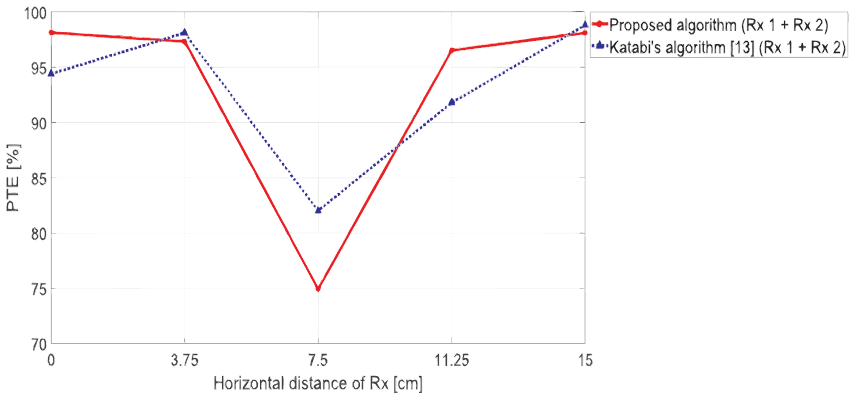
Figure 7. The sum of PTE results for all Rx coil. Proposed algorithm vs. Katabi’s